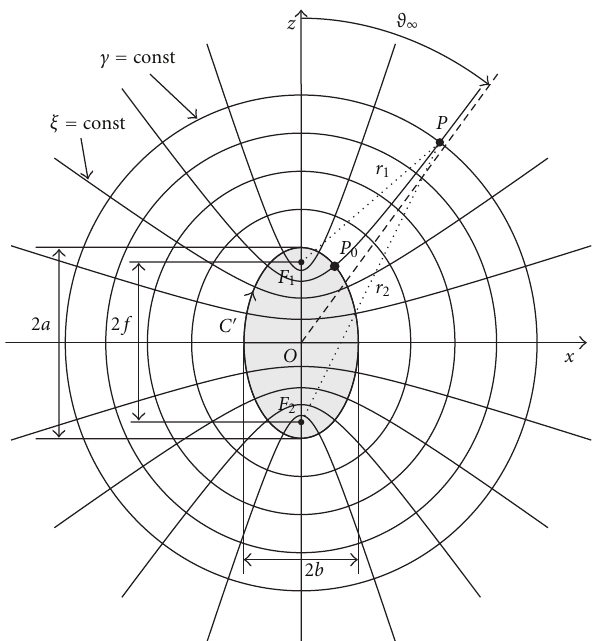
Figure 2: Ellipsoidal source modelling: prolate case.